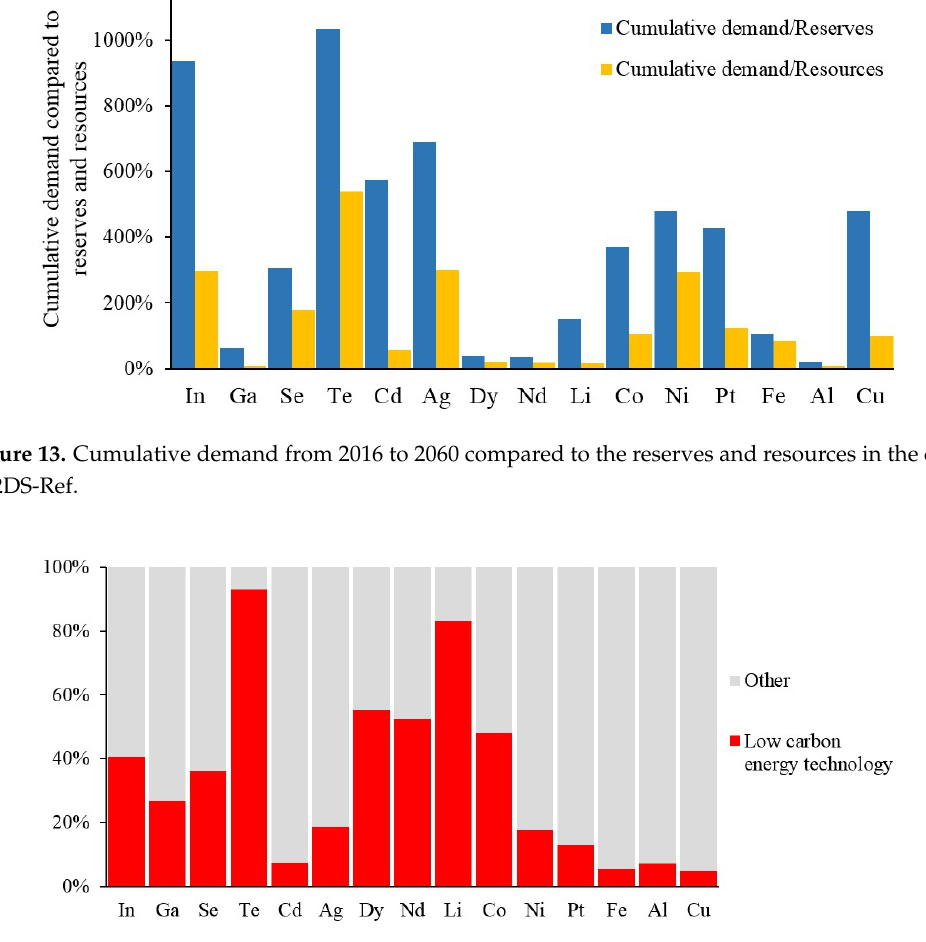
Figure 14. Breakdown of end-uses of cumulative demand from 2016 to 2060 in the case of 2DS-Ref.